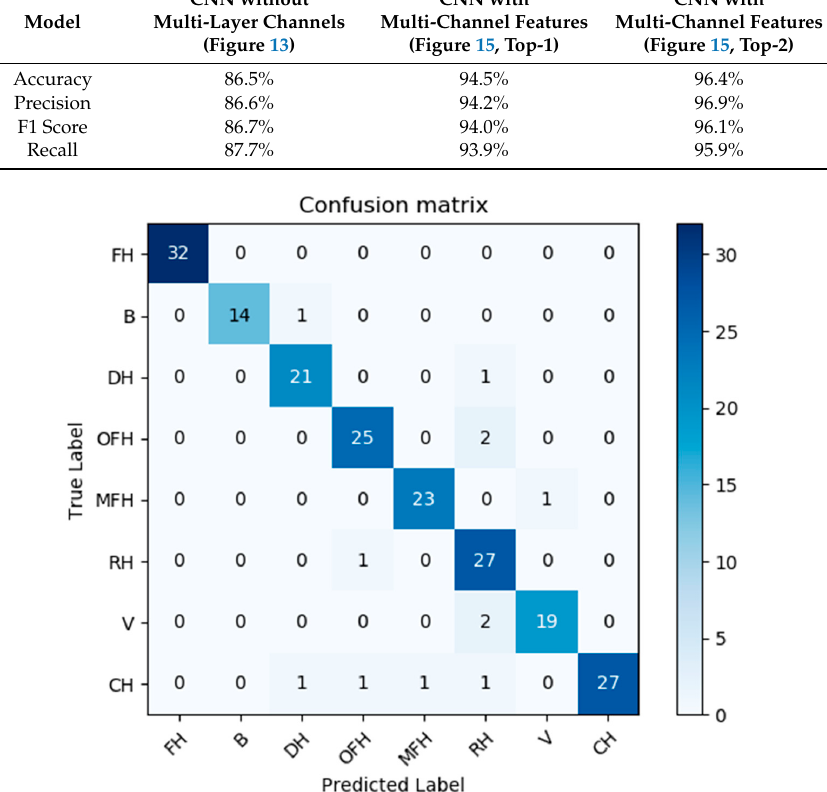
Figure 18. Confusion matrix of the results obtained from Model III while using 200 test images.